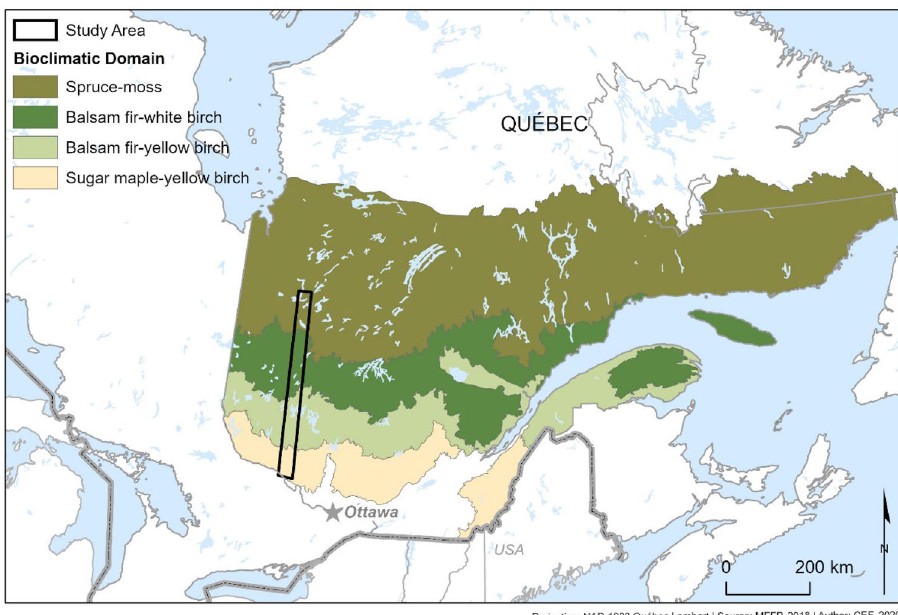
Figure 1. Map of eastern Canada showing the latitudinal transect and different bioclimatic domains covered by our study area. The software ESRI’s ArcGIS Pro 2.8 was used to produce the